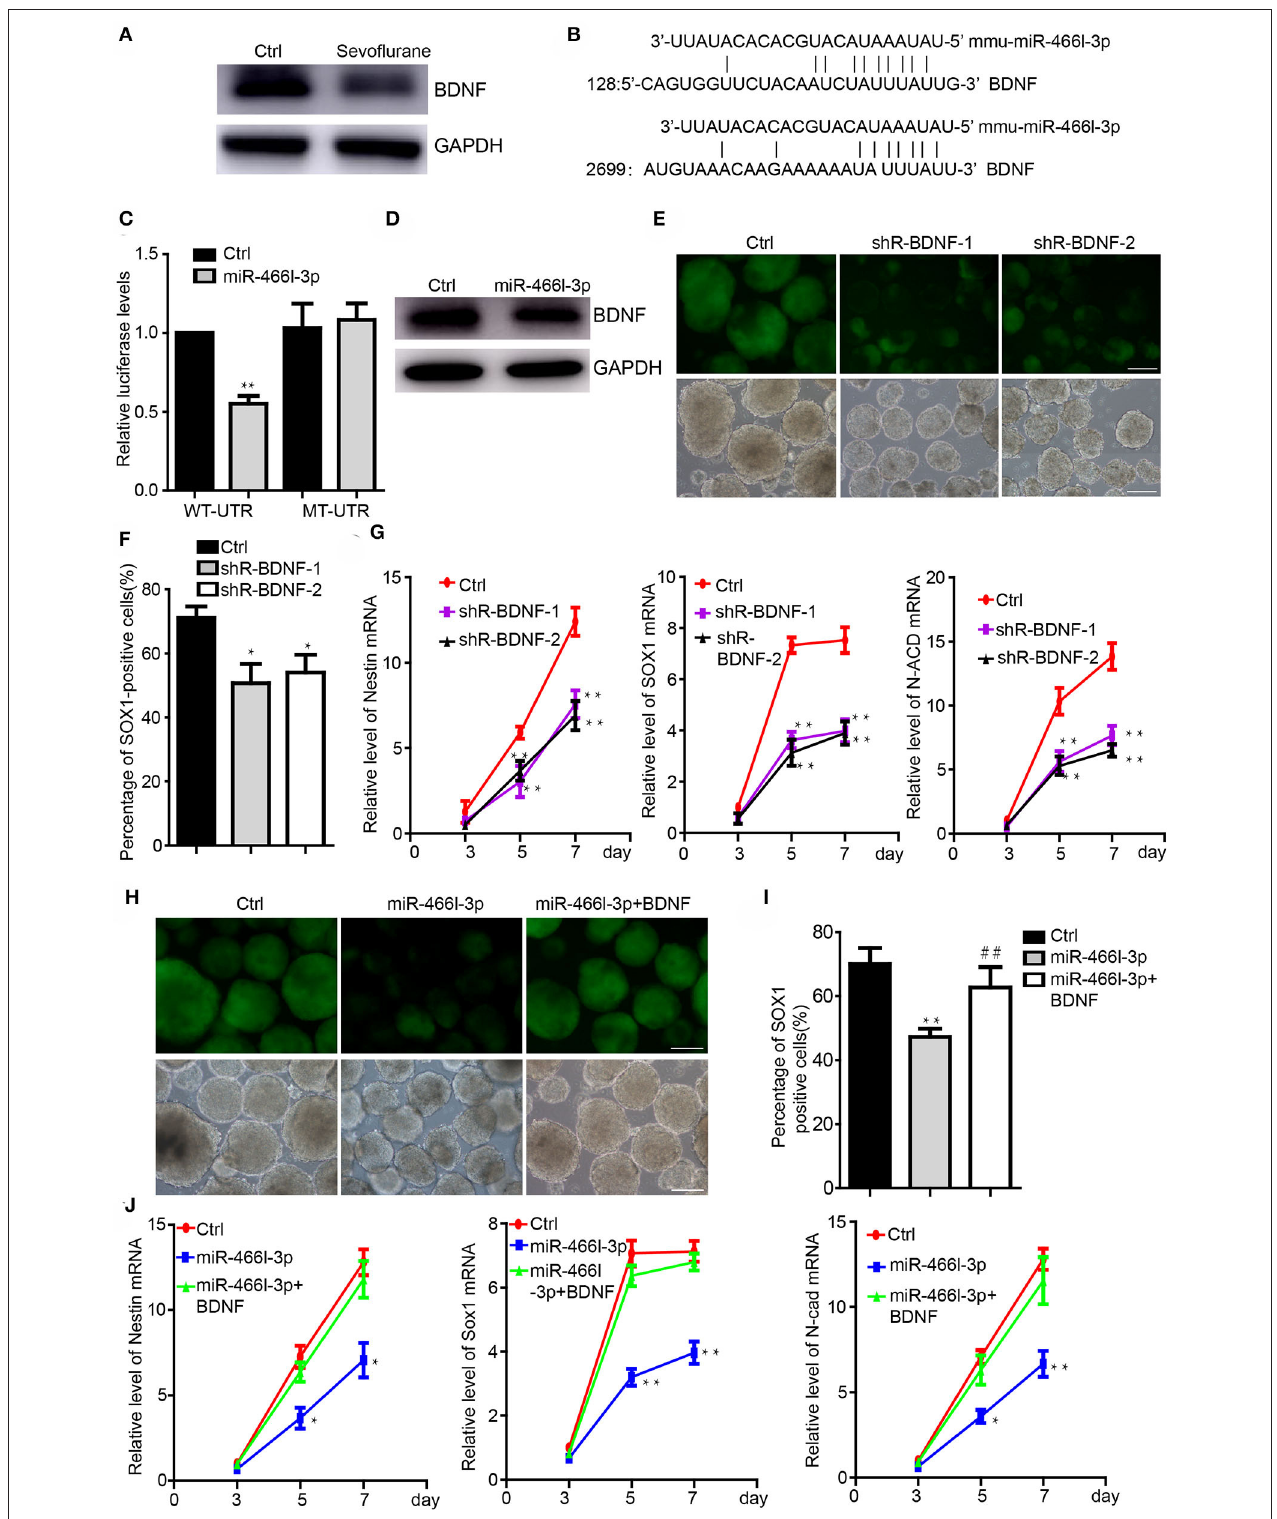
FIGURE 3 | MiR-466l-3p targeted BDNF to mediate neural differentiation. (A) Western blot indicated the downregulation of BDNF cause by sevoflurane treatment in mice hippocampus ( n = 6). (B) Target validation of the binding of BDNF 3 ′ UTR by miR-466l-3p. (C) Luciferase report assay indicated that miR-466l-3p targeted